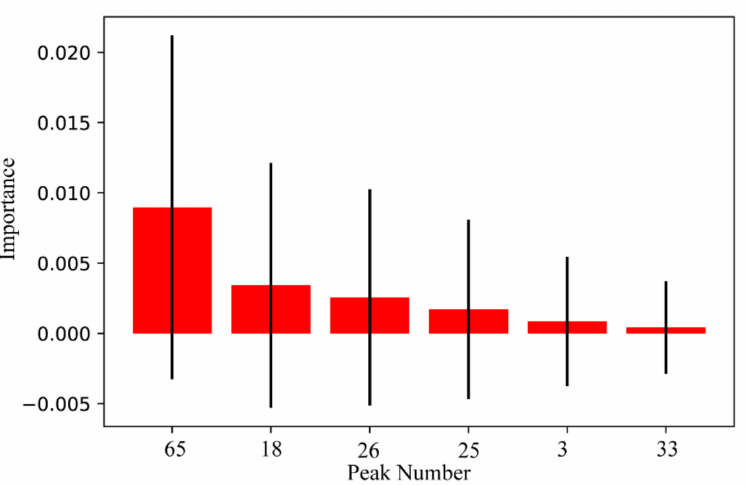
Figure 5. Six quality markers selected by the permutation importance